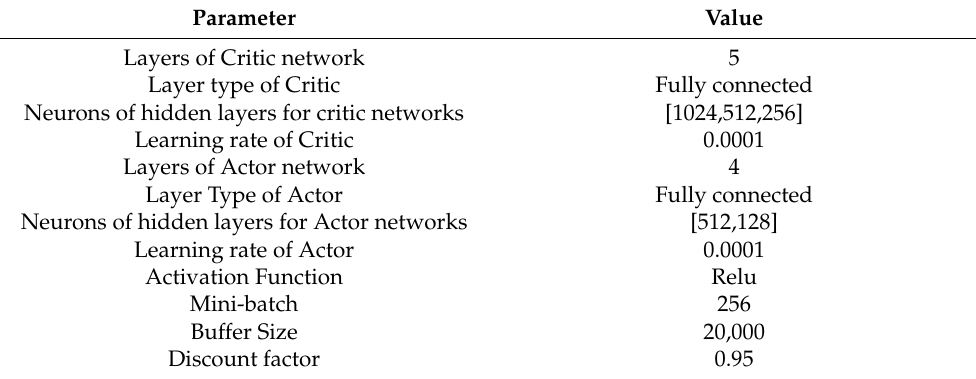
Table 2. The neural network and training parameters